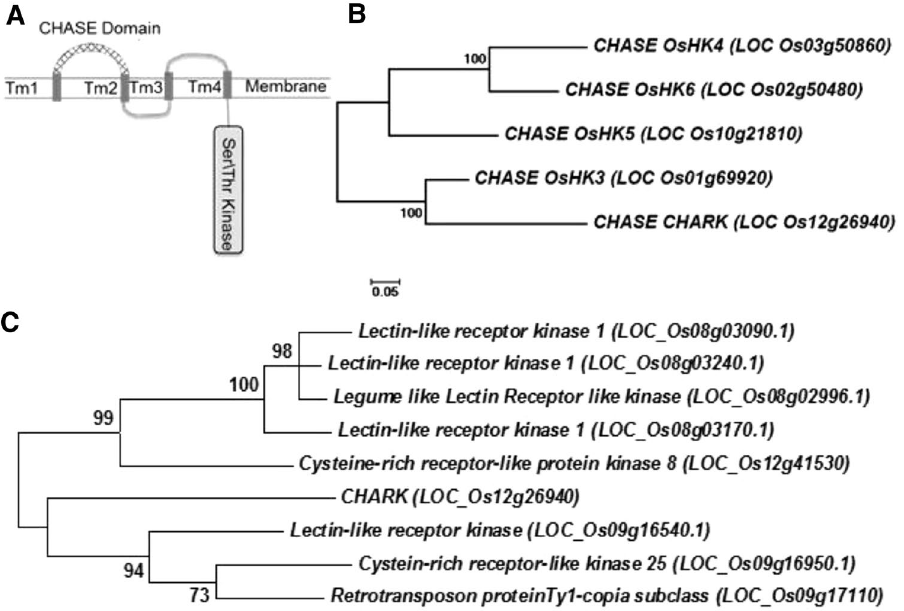
Figure 1. Domain structure and phylogenetic relations of CHARK. ( A ) Domain structure of CHARK. The domain structure of CHARK was determined using the PFAM and the TMHMM programs 23,60 . ( B , C ) Phylogenetic relations of the CHASE and Ser/Thr kinase domains. The phylogenetic most closely related sequences to CHARK were determined by using the sequence of both domains, CHASE and Ser/Thr kinase, respectively, as query in BLAST searches to identify the most closely related sequences in rice. The resulting sequences were aligned using MUSCLE and Maximum Likelihood trees were calculated, respectively, using the MEGA7 program 26 . Tm single membrane-spanning